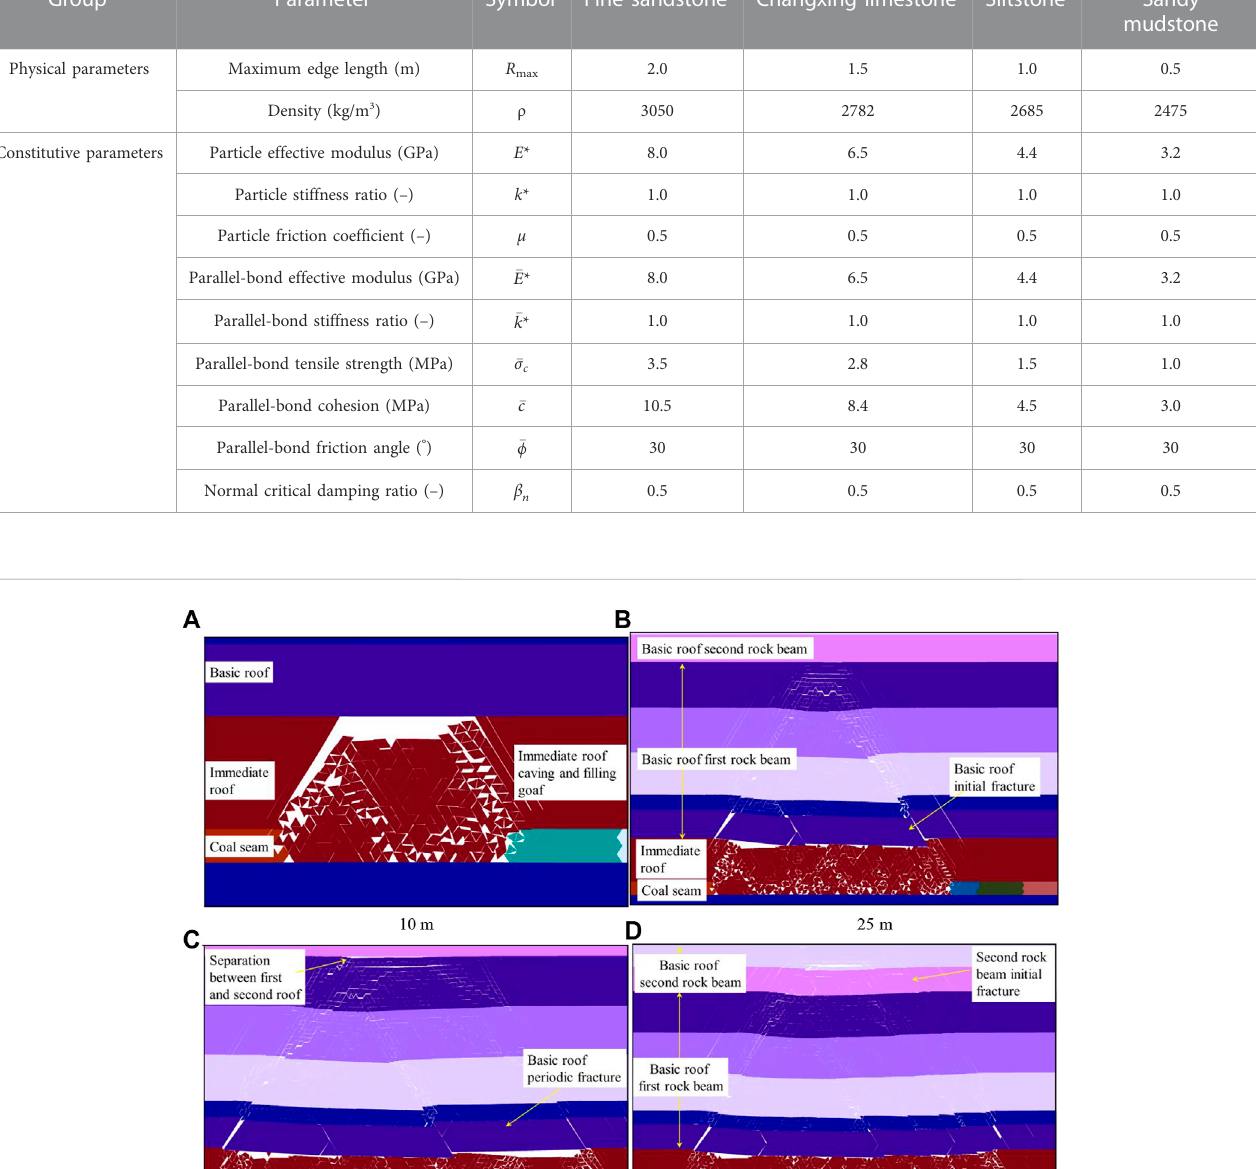
TABLE 8 Calibration results of particle mesoscopic parameters. Group